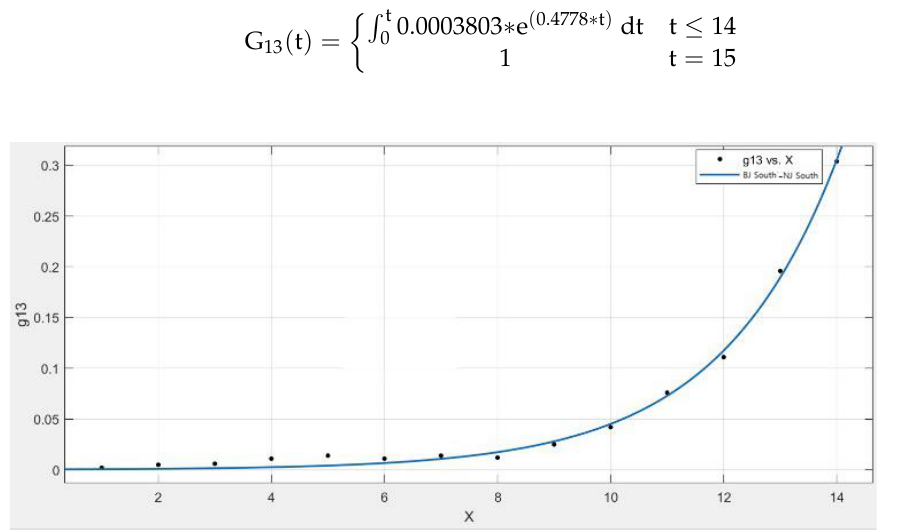
Figure 5. Fitting result of daily ticket-purchasing rate of Beijing South – Nanjing South during the pre-sale period.